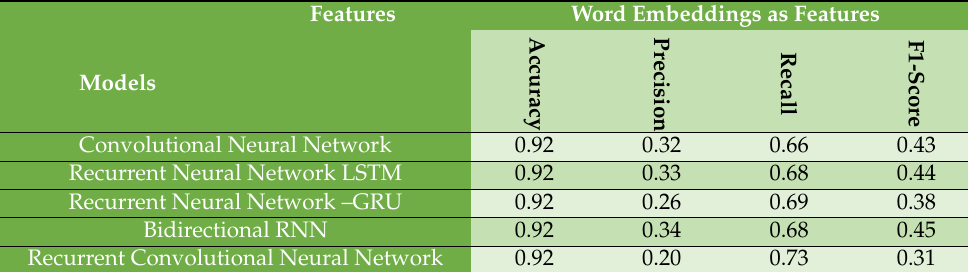
Table 4. Base models